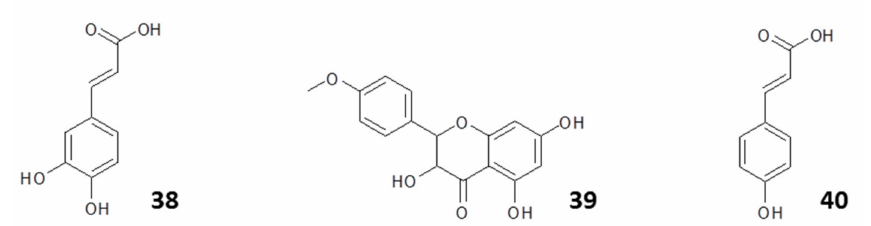
Figure 7. Structures of some compounds isolated from propolis with synergetic activity against Leishmania (Viannia) braziliensis